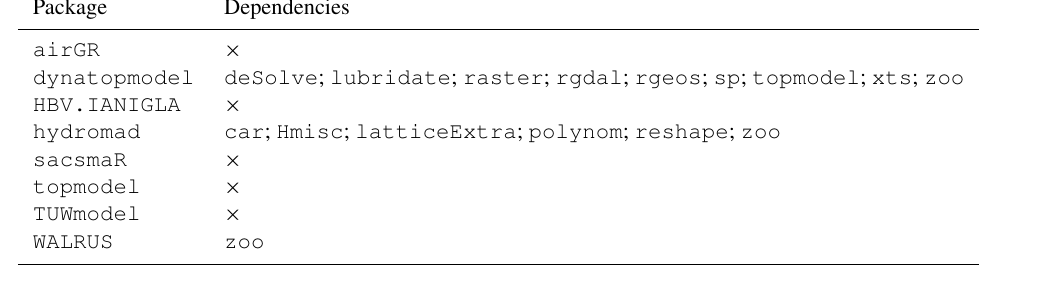
Table 10. Package dependencies. Base packages and recommended packages are not explicitly taken into account in this table.